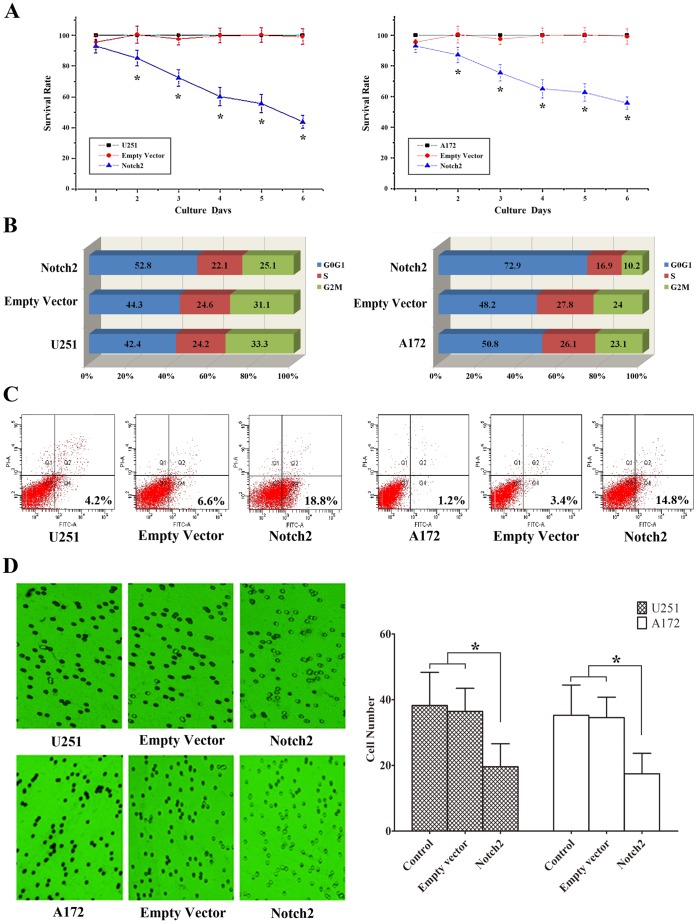

In vitro study of proliferation, apoptosis and invasive ability in U251 cells transfected with Notch1 siRNA.A. Proliferation rate of U251/A172 cells transfected with Notch2 construct determined by MTT assay. B. Cell cycle analysis of U251/A172 cells transfected with Notch2 construct examined with flow cytometry. C. Apoptosis of U251/A172 cells transfected with Notch2 construct detected with Annexin V staining by flow cytometry. D. Invasive ability of U251/A172 cells transfected with Notch2 construct examined by transwell assay. *: p<0.05.